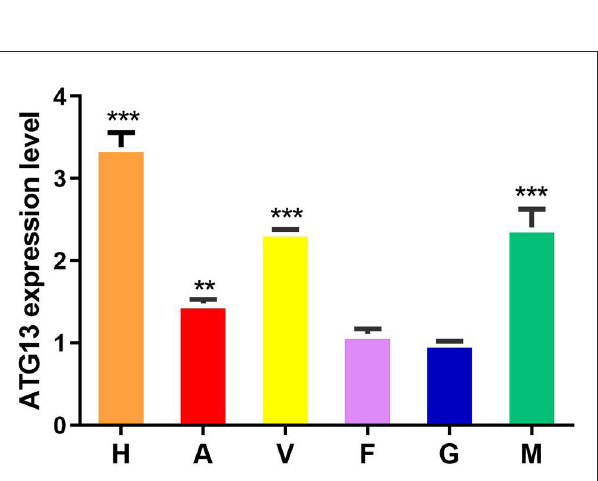
FIGURE6 Expression analysis of TgATG13 gene in different tissues of blood clam. The expression level of TgATG13 gene in different tissues was investigated using qRT-PCR with 18S rRNA as the internal control. H represents hemocytes, A represents adductor muscle, V represents visceral mass, F represents foot, G represents gill, and M represents mantle. Error bars represent the mean ± S.D. ( n = 3). ** P < 0.01, *** P < 0.001.